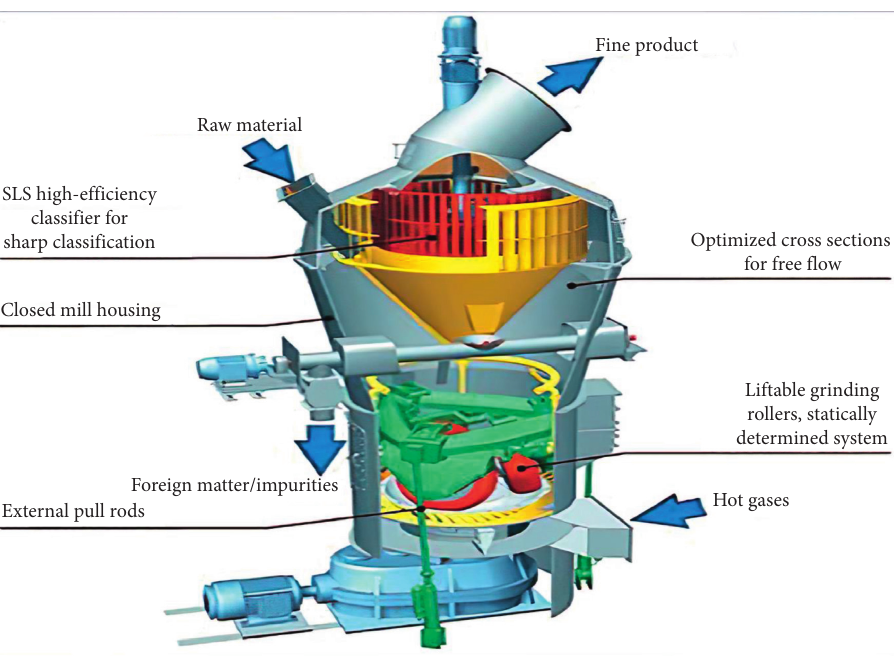
Figure 7: Vertical roller mill.